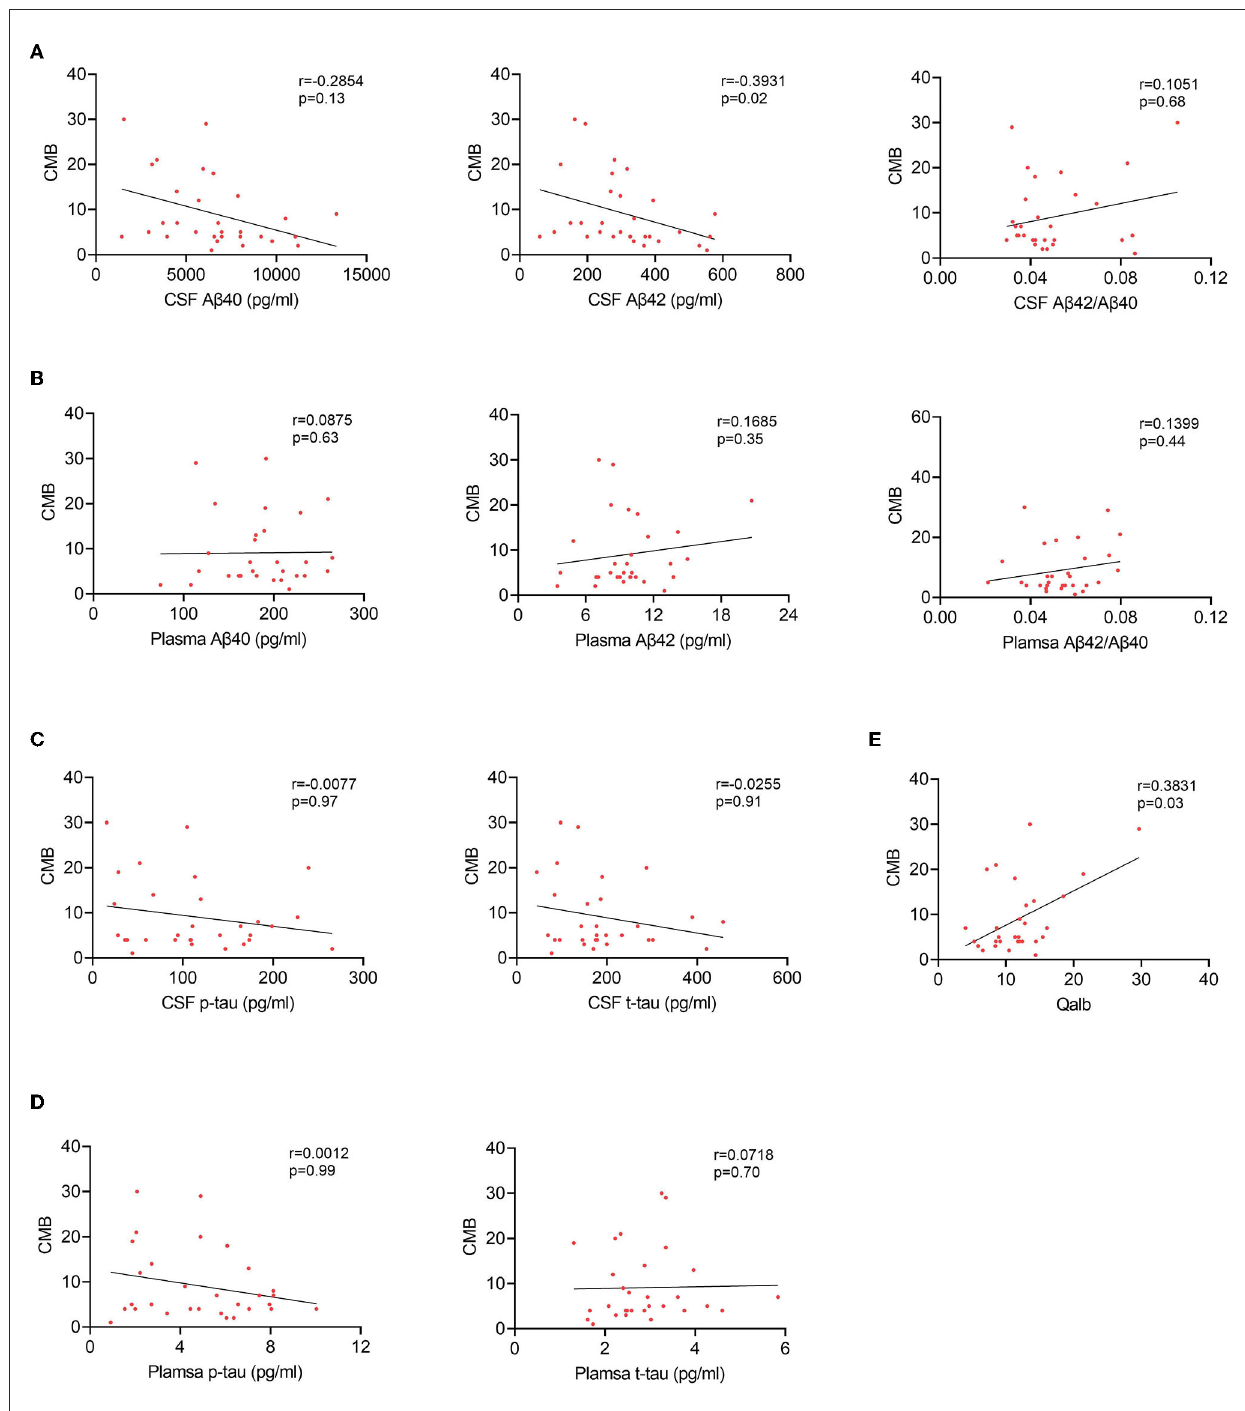
FIGURE4 Correlation between CMB and fluid biomarkers in patients with AD with CMB. (A) Correlation between CSF A β and CMB. (B) Correlation between plasma A β and CMB. (C) Correlation between CSF tau and CMB. (D) Correlation between plasma tau and CMB. (E) Correlation between Qalb and